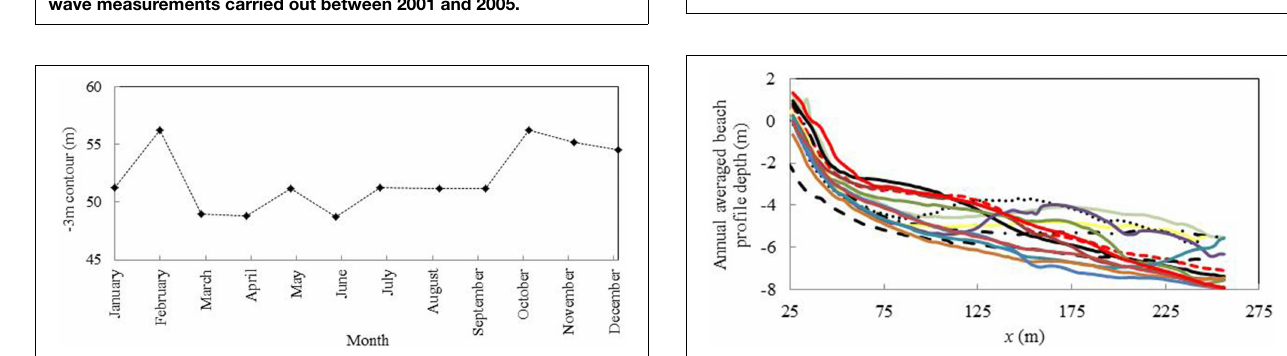
FIGURE 6 | Seasonally averaged beach profiles at J-O Coast. Black lines-seasonally averaged beach profiles, red lines—standard deviation.